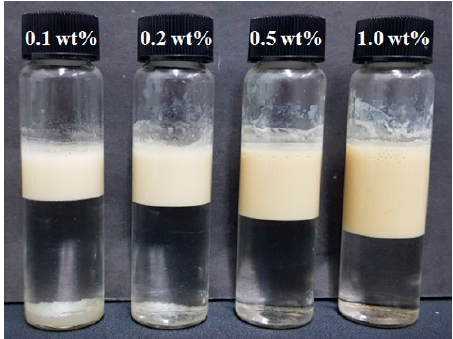
Figure 5. A photograph of PMDA-ODA particle-stabilized n -hexadecane-in-water Pickering emulsions prepared at different particle concentrations (0.1 – 1.0 wt %).